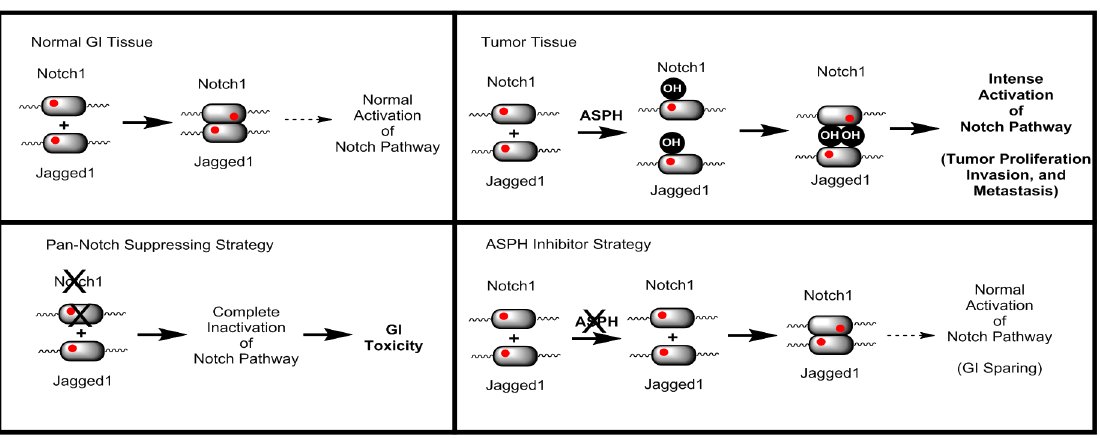
Figure 2. Illustration of NOTCH signalling for normal GI, tumour tissue, pan-notch suppressing strategy (such as γ -secretase inhibitor), and anti-ASPH GI sparing activity.